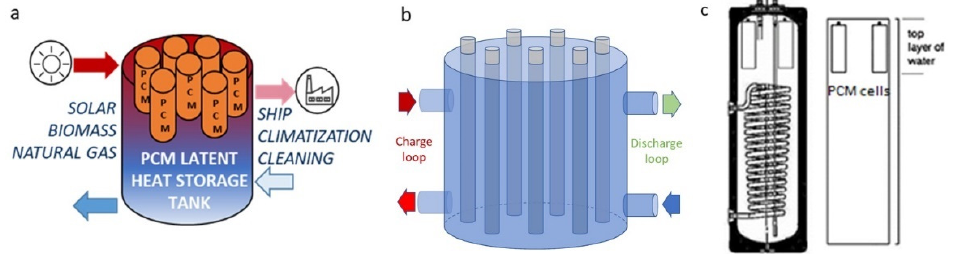
Figure 2. ( a ) Diagram of PCM-TES integration; ( b ) water storage tank with cylindrical PCM modules inside (adapted from [18]); ( c ) hybrid heat storage tank with internal heat exchanger coil and PCM capsules (with copyright permission from Elesvier) [25].